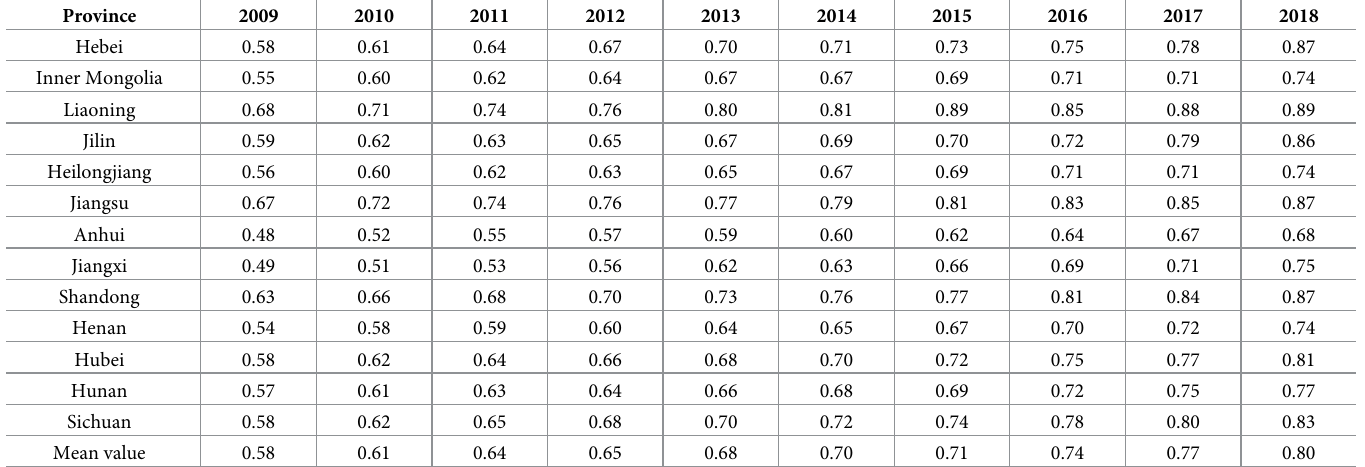
Table 5. Degree of coordination coupling between the Internet development level and agricultural ecological